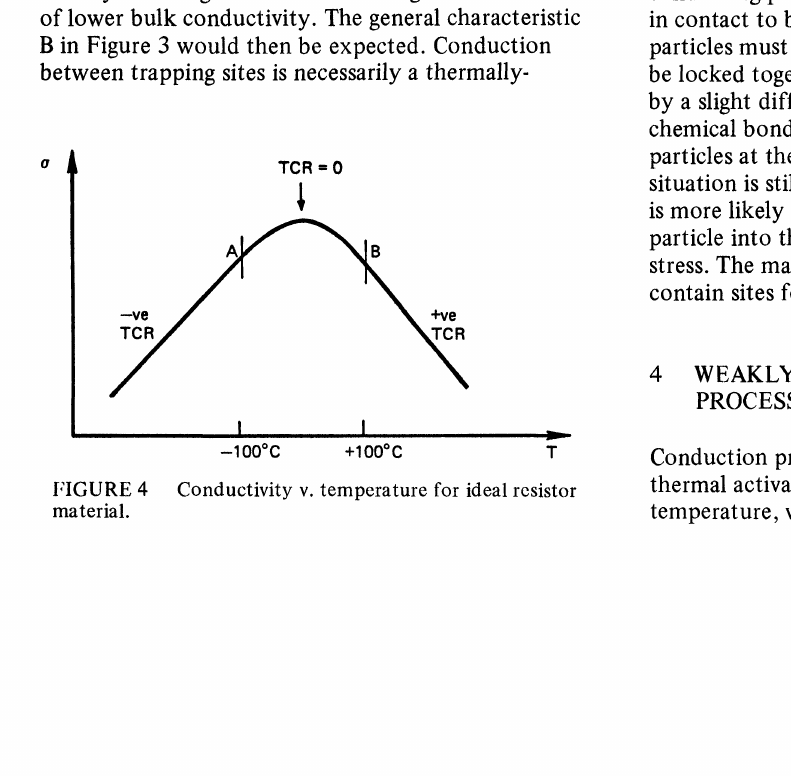
Conductivity v. temperature for ideal resistor